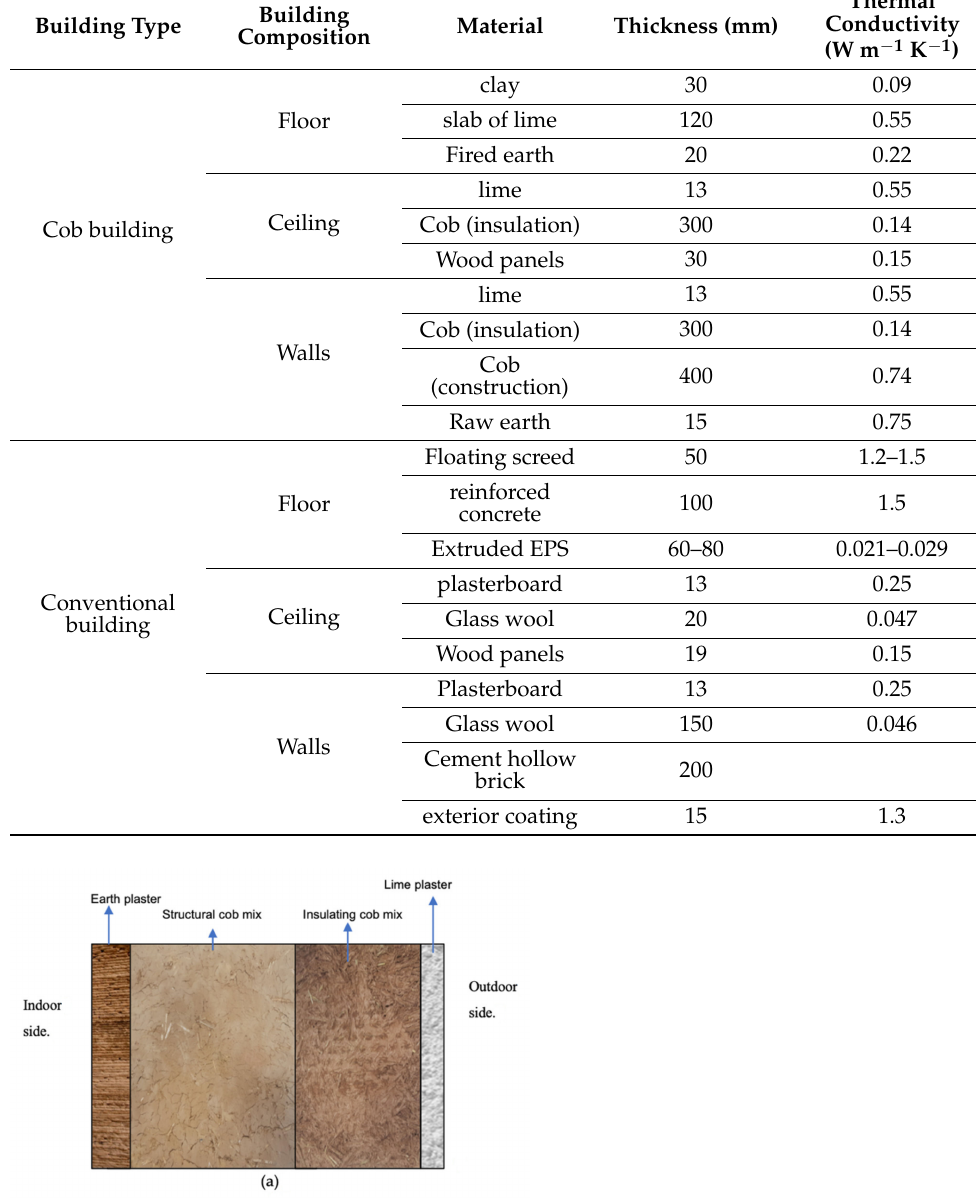
Table 4. The walls, ceiling, and floor composition for cob and conventional buildings.